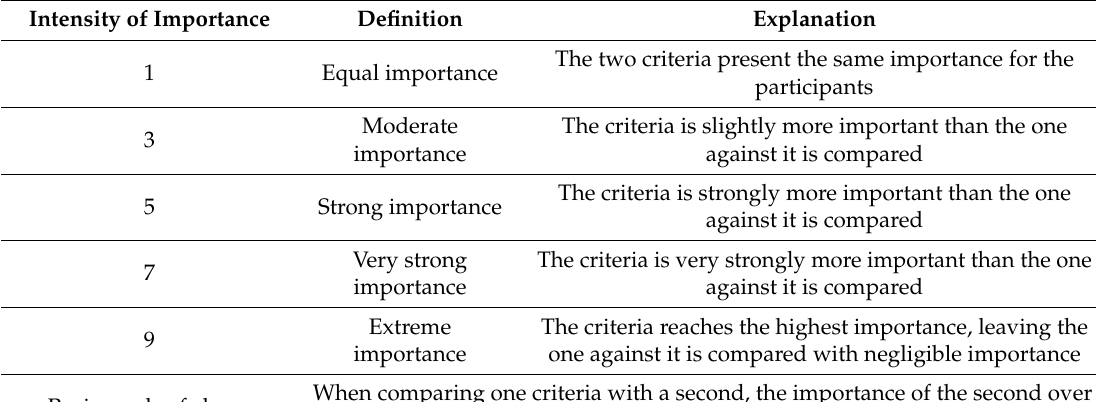
Table 2. The fundamental scale of absolute numbers. Adapted from [35].